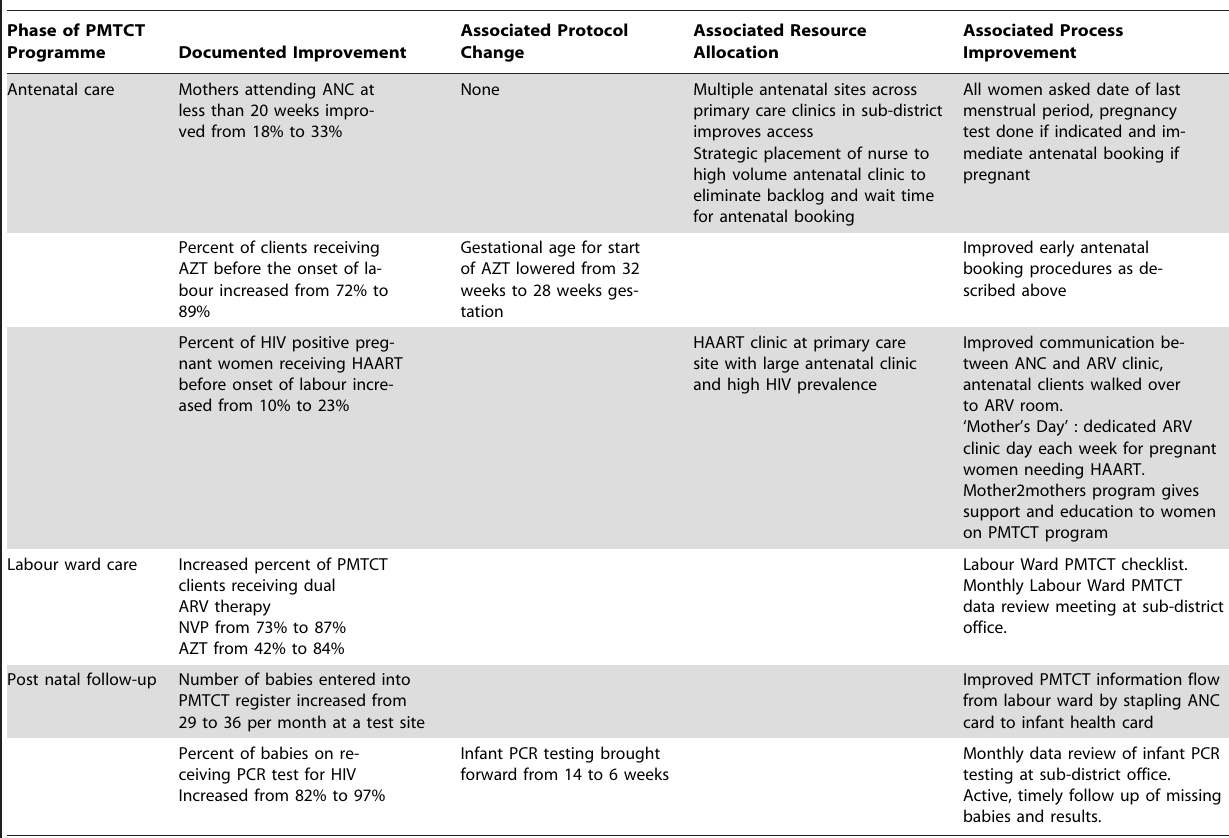
Table 1. Summary of Protocol Changes, Resource Additions and QI Process Improvements that led to documented